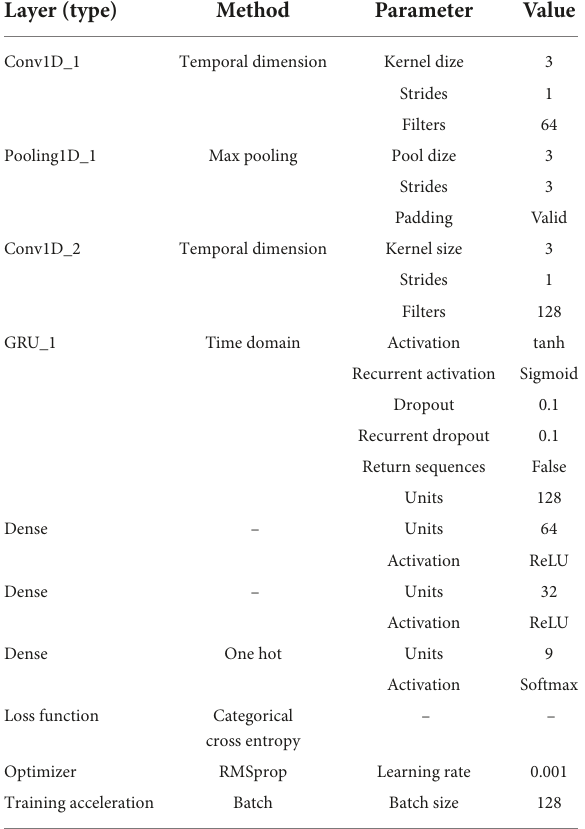
TABLE 3 Summary of sFE-Net.